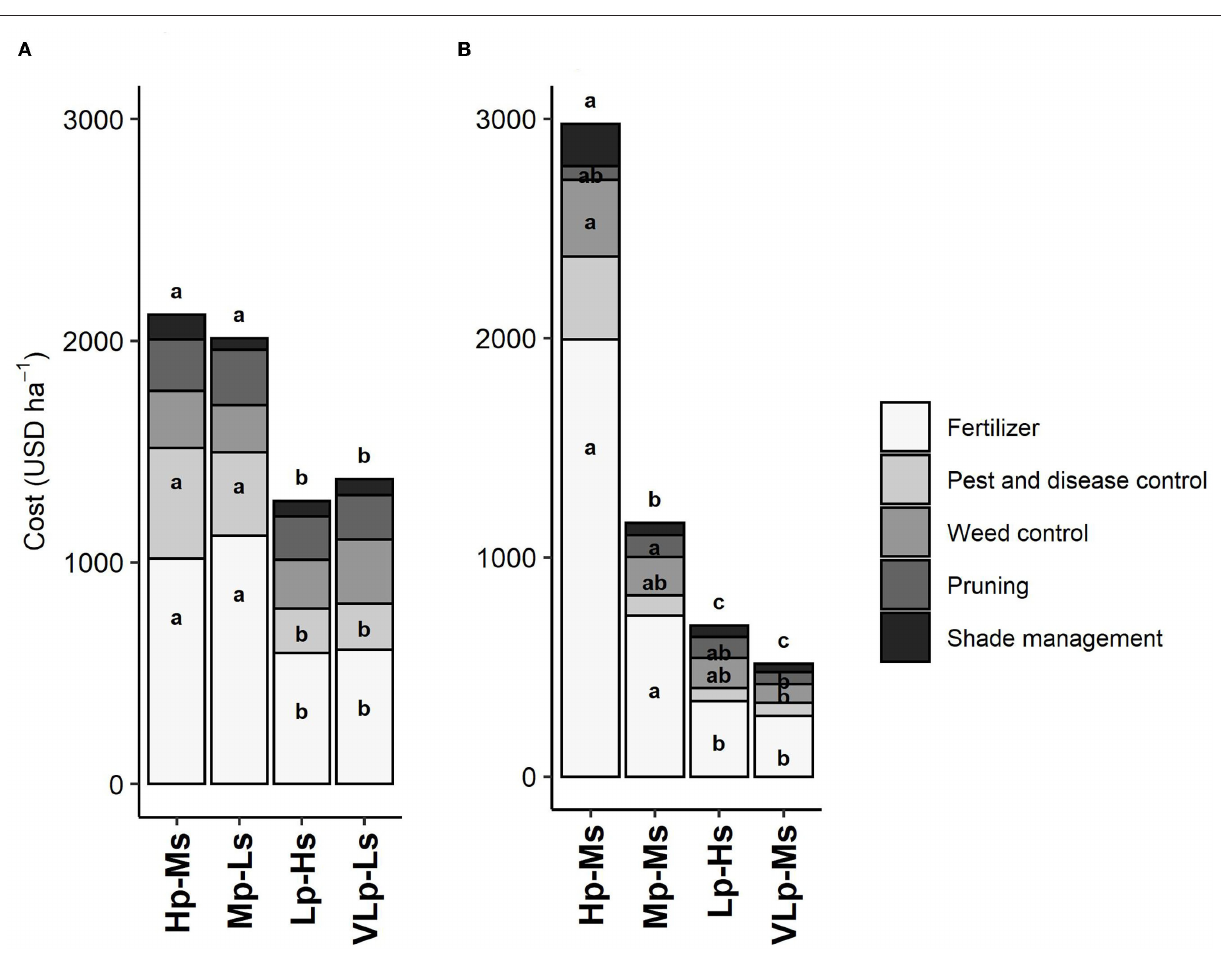
FIGURE 1 | Agronomic costs (USD ha − 1 ) by coffee plantation typology in (A) Costa Rica and (B) Guatemala. The letters at the top of the bars indicate a significant difference (p < 0.05) in total cost. The letters in the bars indicate significant differences between typologies for each type of cost. Key to typologies: Hp-Ms, High